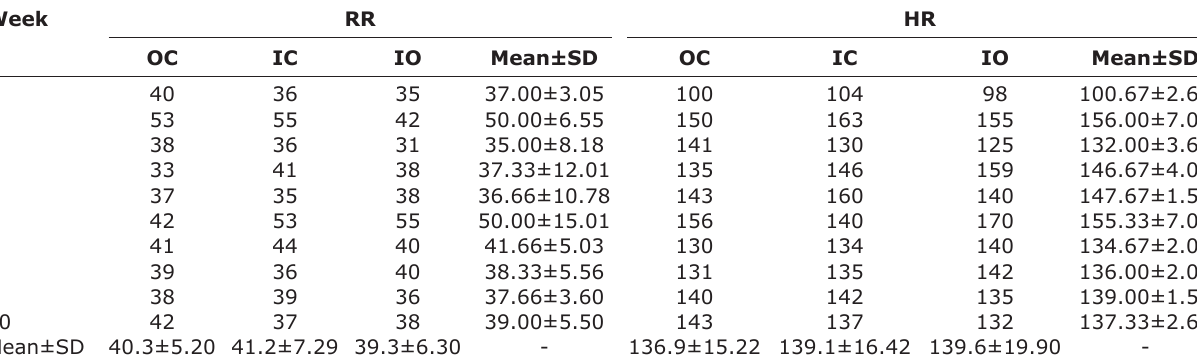
Table-2: RR (breath/min) and HR (beats/min) of angora rabbits under control condition.